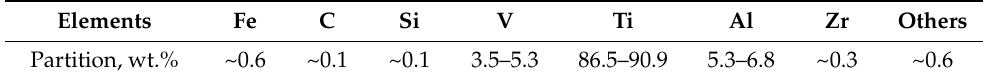
Table 1. Chemical composition of Ti-6Al-4V alloy identified by EDX analysis. Elements